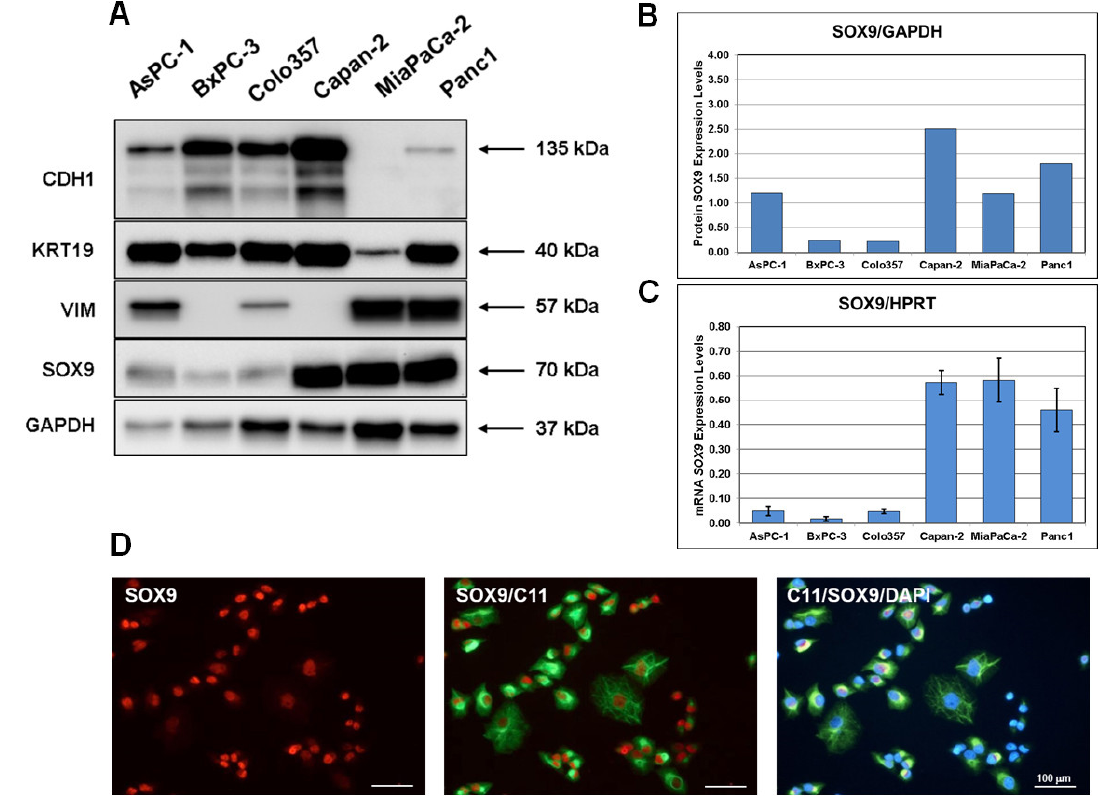
Figure 1. SOX9 protein and SOX9 mRNA expression in AsPC-1, BxPC-3, Colo357, Capan-2, MiaPaCa-2, and Panc1 cells. ( A ) Western blot analysis of the expression of E-cadherin (CDH1), cytokeratin-19 (KRT19), vimentin (VIM), SOX9, and GAPDH in the investigated cell lines. Pancreatic cancer cells were seeded in 6-well plates (0.5 × 10 6 cells per well). After 48 h, cell lysates were prepared by adding SDS sample buffer (200 µL per well). ( B ) Densitometric quantitation of Western blots from ( A ). The levels of the SOX9 protein were normalized to the levels of the GAPDH protein. ( C ) Real-time qPCR analysis of the mRNA expression of SOX9 in pancreatic cancer lines. The results are presented as the mean ± SEM of three independent experiments and normalized against the HPRT expression. ( D ) Immunofluorescence imaging of the SOX9 expression in Panc1 cells. Cells were stained for total cytokeratin (green) and SOX9 (red). Nuclei were stained with DAPI (blue). Scale bar = 100 µm.